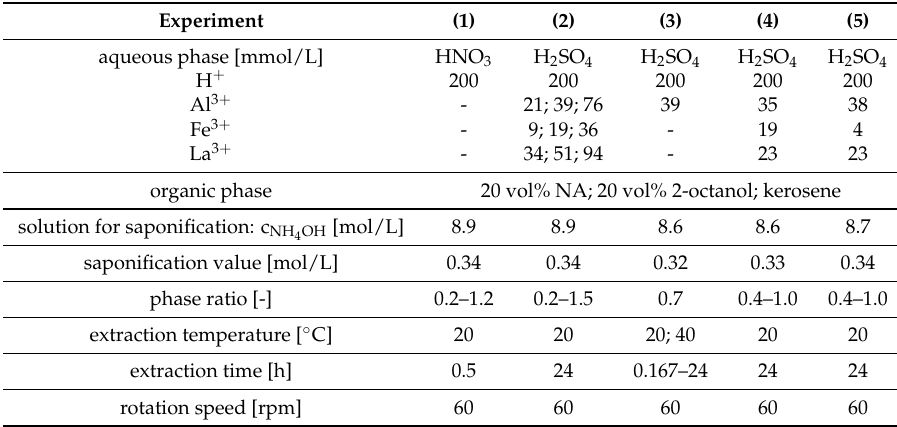
Table 2. Experimental conditions for extraction experiments: (1) stability of microemulsion; (2) extraction equilibrium experiments from single-component solutions; (3) kinetics of Al 3 + extraction; (4) extraction equilibrium experiments from double-component solutions; (5) removal of aluminum and iron from ternary-component